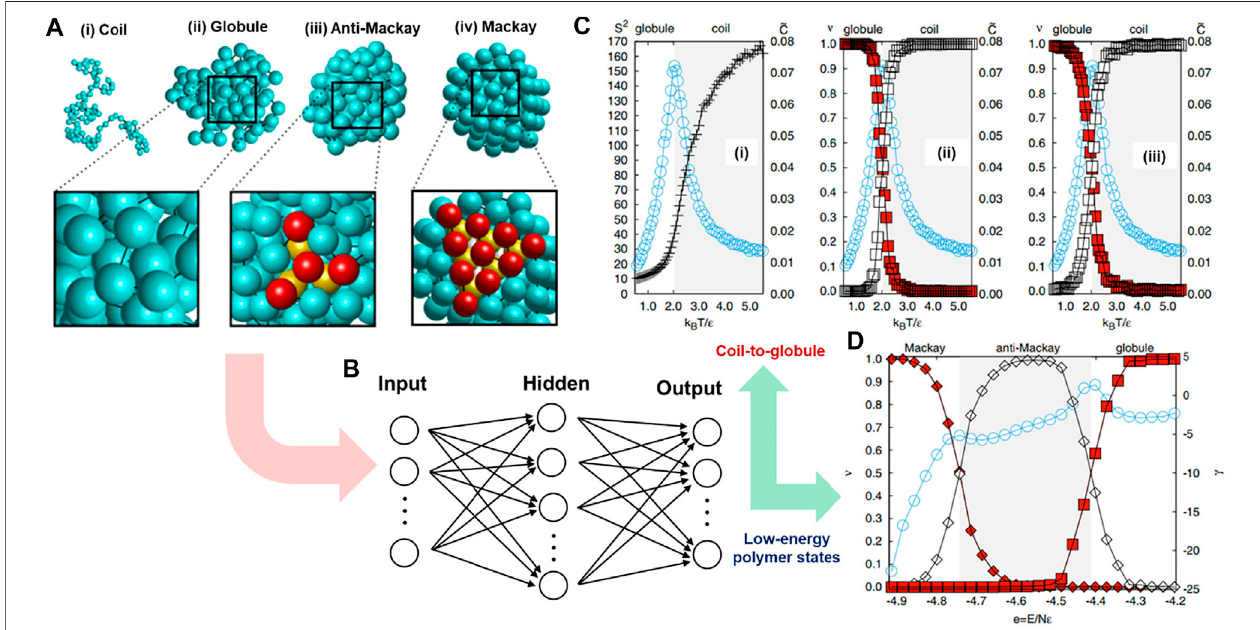
FIGURE 4 | Identifying polymer states by machine learning. (A) Typical con fi gurations of a polymer chain in states of (i) coil, (ii) globular, (iii) anti-Mackay, and (iv) Mackay. (B) Polymericcon fi gurationisimportedintoafullyconnectedFNNs.Thecirclesrepresentnodesconnectinglayerbylayerviaweightandactivationparameters. Thenumberofinputnodesis3NrepresentingthenumbersofspatialcoordinatesoftheN-monomerchain,whilethenumberofoutputnodesdependsonthenumberof con fi gurations that will be classi fi ed. (C) FNNs classi fi es polymer con fi gurations under coil-to-globule transition: (i) Monte Carlo (MC) shows phase transition point fromcoiltoglobuleatk B T/ ϵ ≈ 2.0correspondingtothepeakofspeci fi cheatvalueC;themeanFNNoutput( ν values)canbecorrectlyevaluatedforglobule(redsquares) or coil(white squares)basedoneither original (ii) ornormalized (iii) coordinates ofmonomers withtheaccuratetransitionpoints (k B T/ ϵ )comparedtoCGMDsimulations (i) . (D) FNNs model can classify Mackay ( fi lled diamonds) and anti-Mackay (open diamonds) based on the mean FNNs output ( ν values), correctly compared with transition points represented by a speci fi c heat-like curve (Mackay-anti-Mackay-globule) derived from independent MC simulations. Figure was reproduced from Ref. (Wei et al., 2017) with